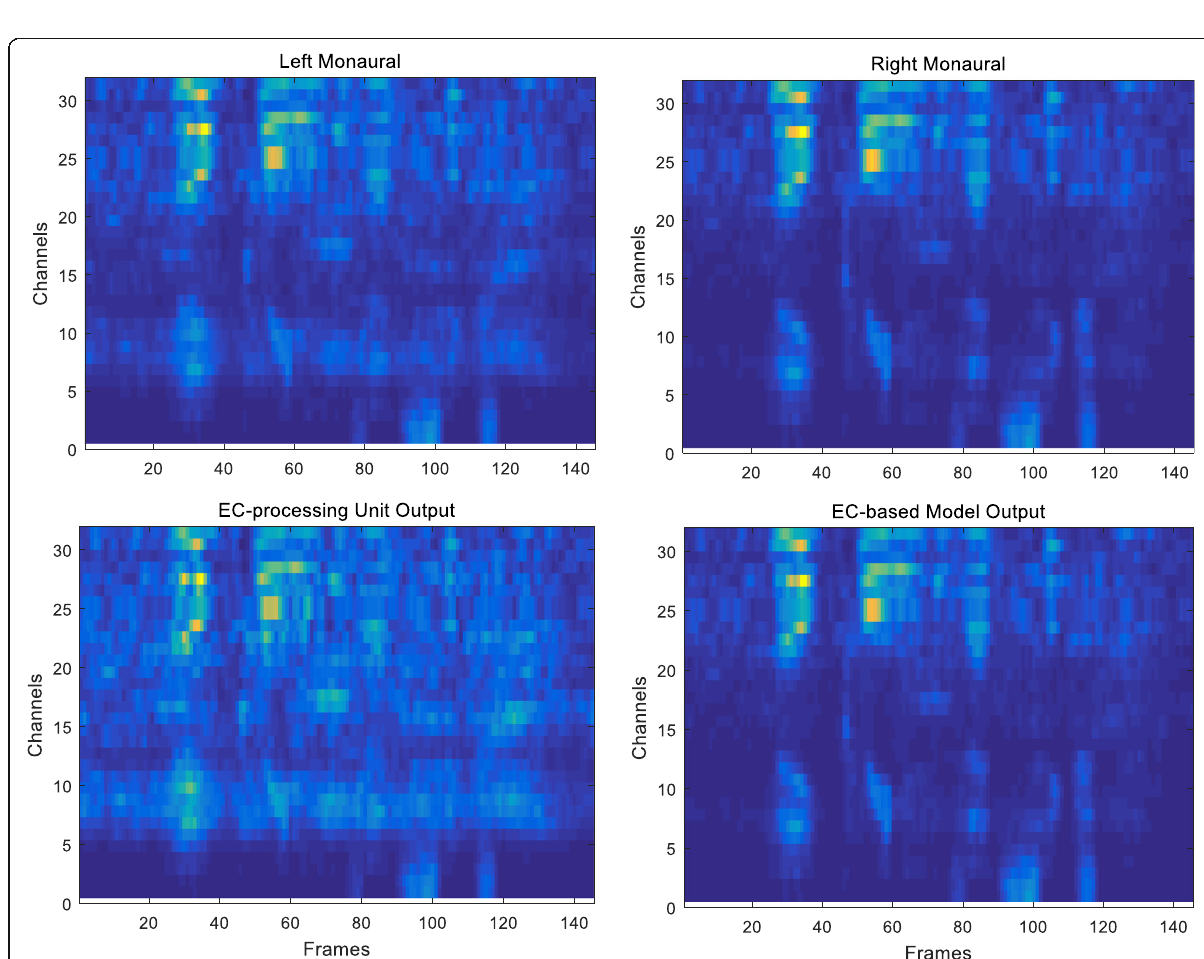
Fig. 5 Cochleagrams of the left monaural, right monaural, and binaural EC-processed signals, and the EC-based model